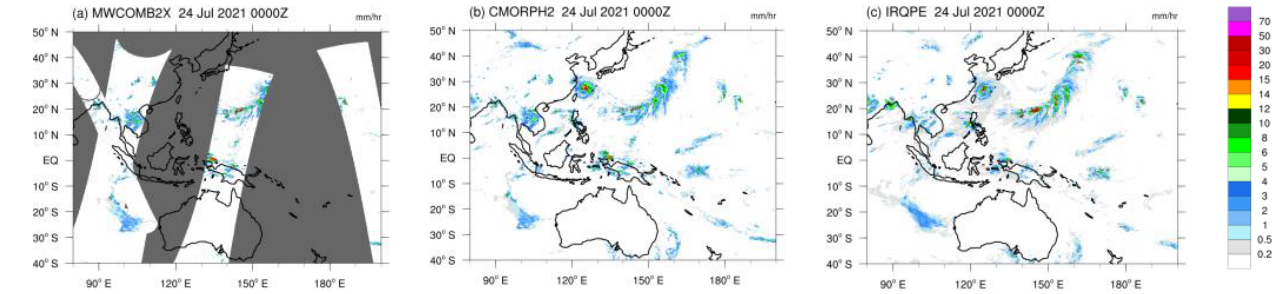
Figure 1. A rain map comparison by a selected case on 24 July 2021 0000Z. ( a ) MWCOMB2x, ( b ) CMORPH2, ( c ) IRQPE. The area with missing value (no data) was colored in deep gray.